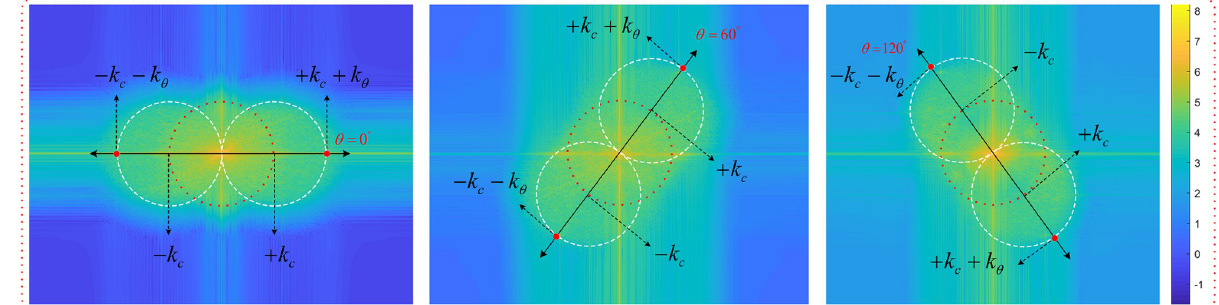
Fig 5. Combined frequency spectrum of images shifted by the k